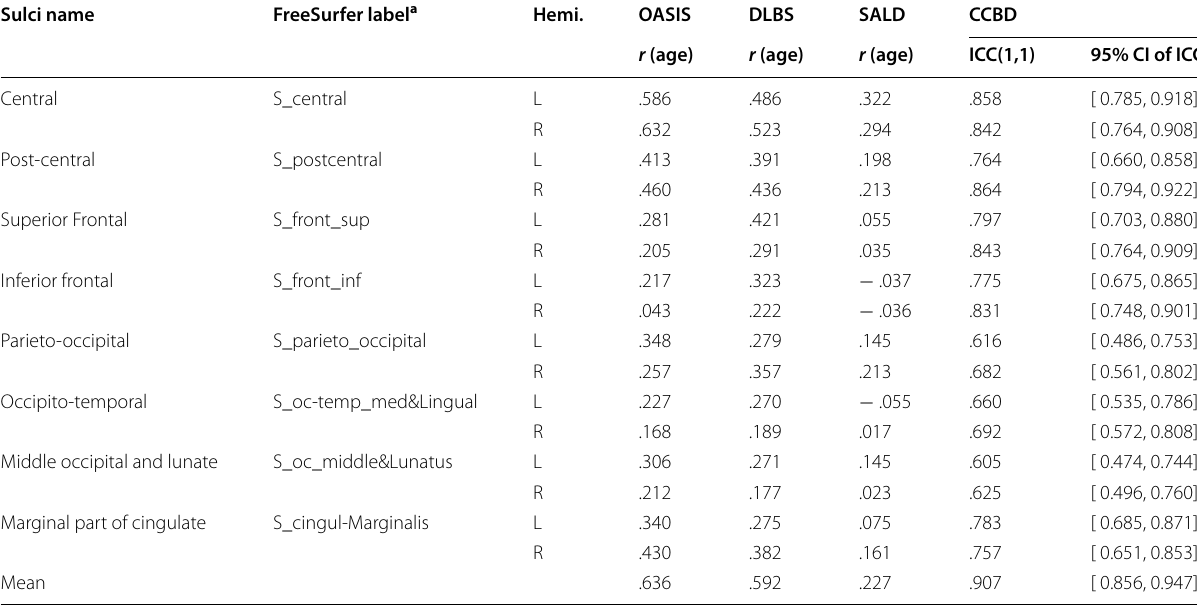
Table 1 Correlations between sulcal width and age for each sulci and hemisphere, for each of the three lifespan datasets examined